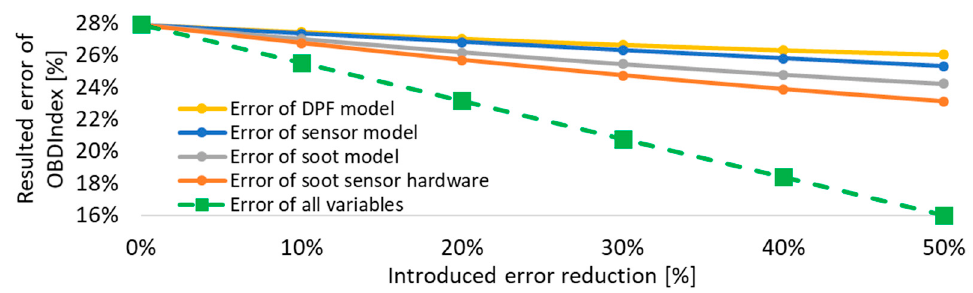
Figure 16. OBD index sensitivity analysis. A reduction of the inaccuracies of the sensor hardware and the soot model are the dominant factors for a reduced overall error.